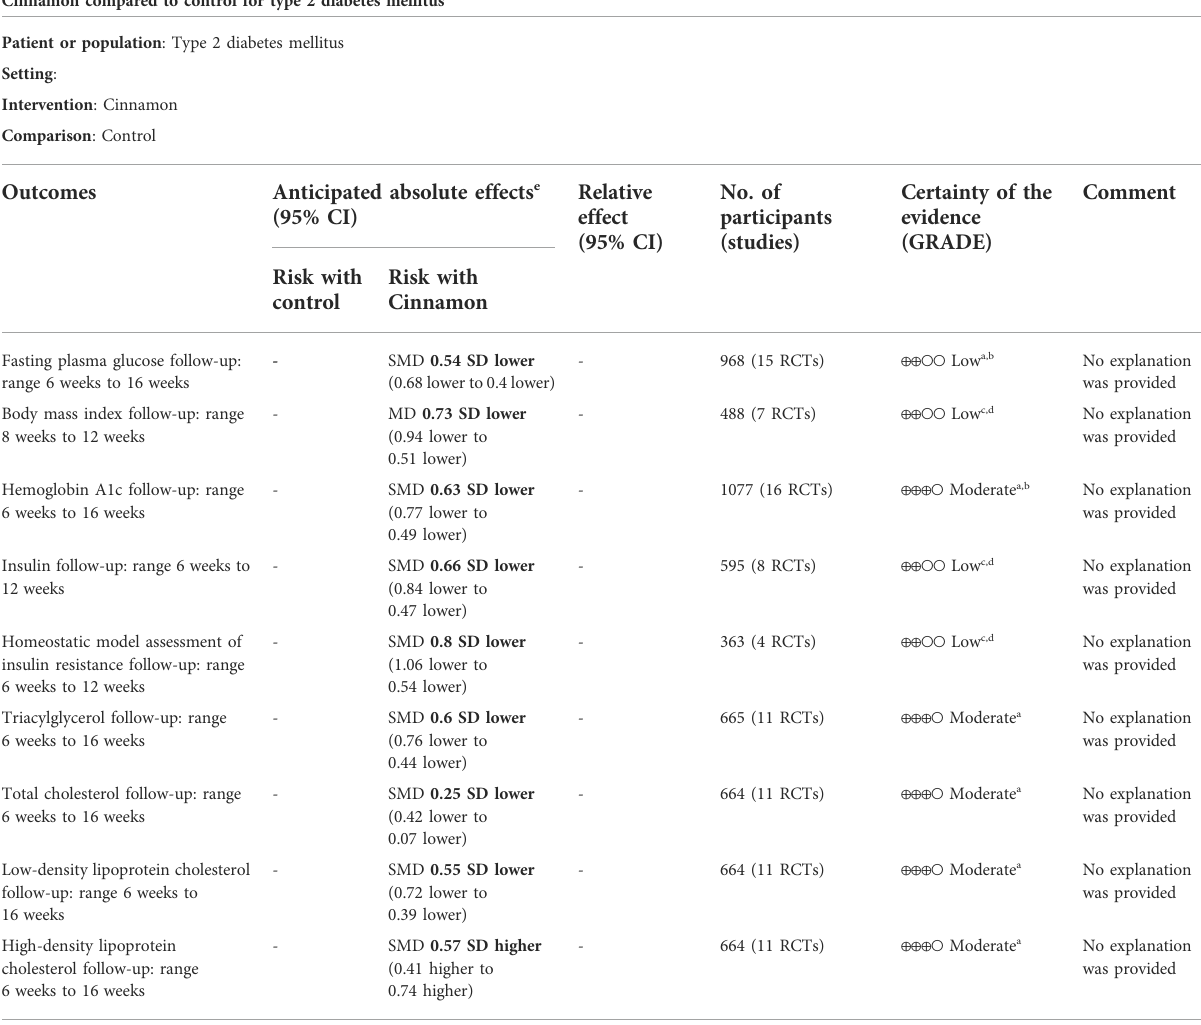
TABLE 3 Grading of Recommendations Assessment, Development, and Evaluation (GRADE) approach evidence certainty and summary of fi ndings of the clinical important outcomes. Summary of fi